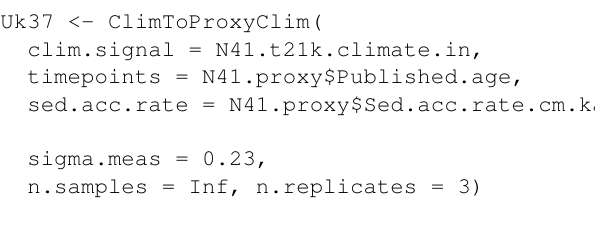
Figure 6. Forward modelled proxy-based temperature reconstructions for Mg / Ca with 1 and 30 tests of G. ruber , and for U K runs of the forward model are